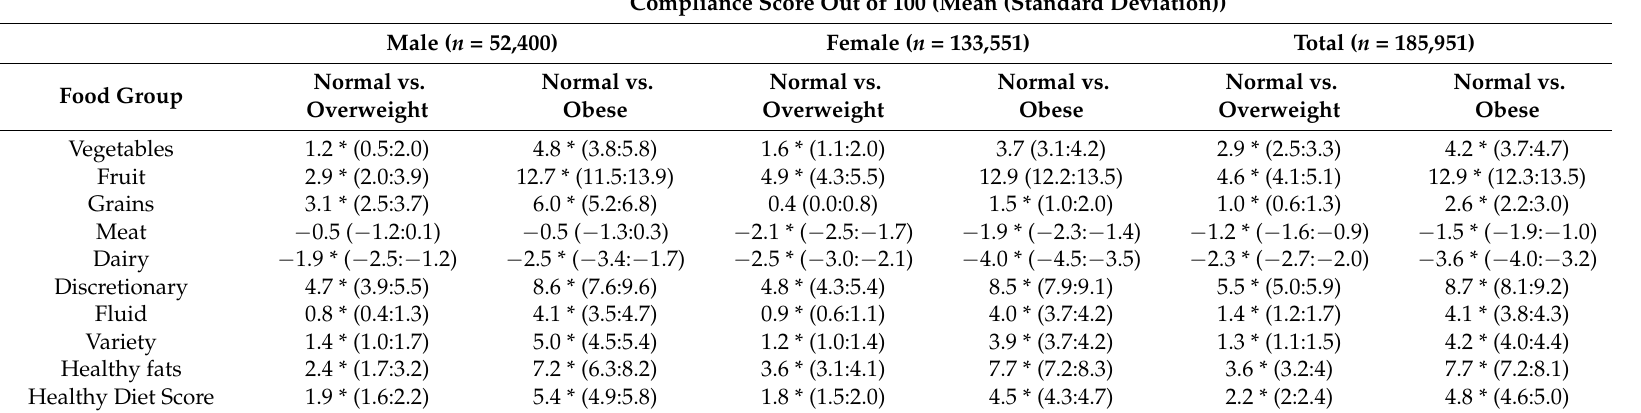
Table 3. Difference in Dietary Guideline compliance scores (out of 100) between normal and overweight, and normal and obese adults by gender 1 .